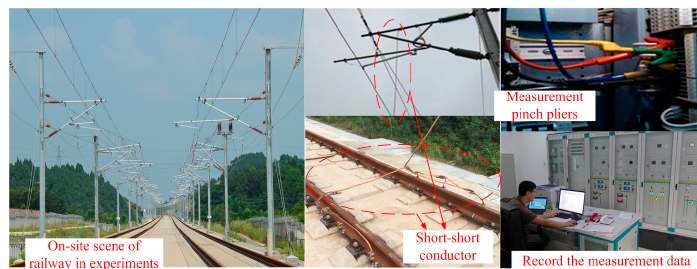
Figure 7. Scene diagrams of the short-circuit experiments.